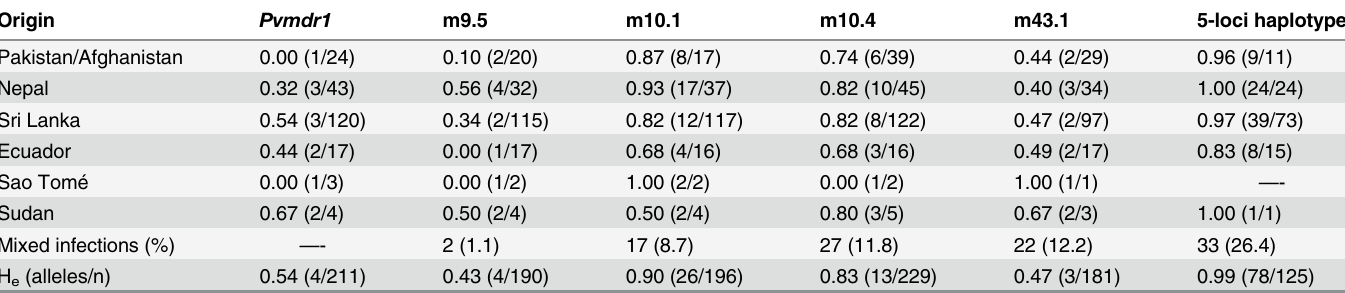
Table 2. Allelic diversity measured by expected heterozygosity (H e